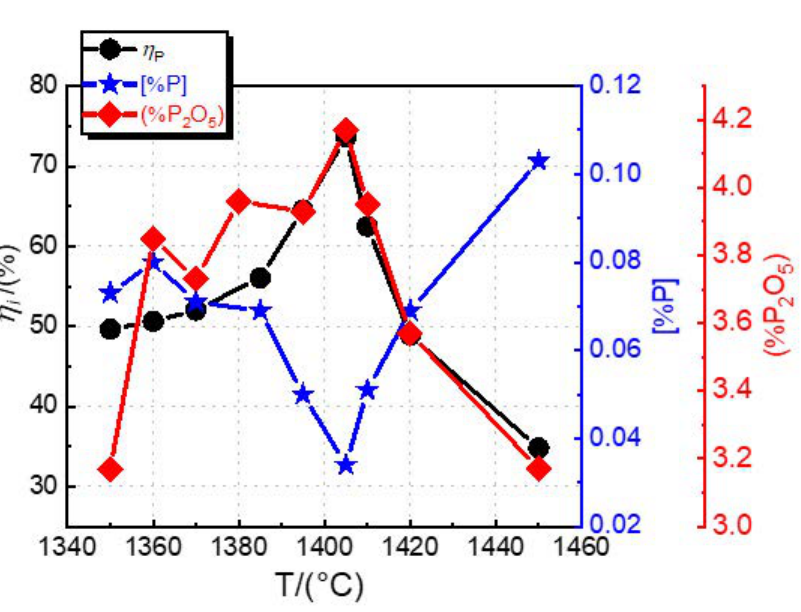
Figure 3. Effect of dephosphorization endpoint temperature on the dephosphorization ratio, phosphorus content in hot metal, and P 2 O 5 content in dephosphorization slag at the endpoint of